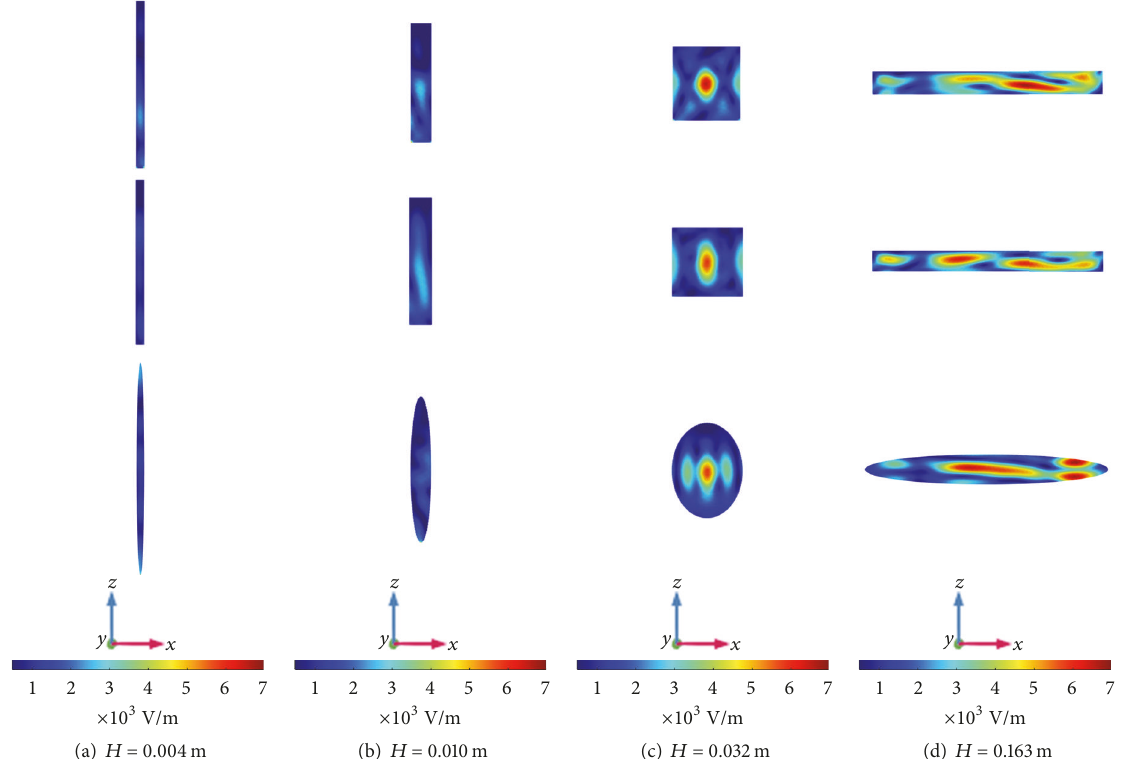
Figure 19: Electromagnetic field distribution on ZX axial middle cross section in Orientation